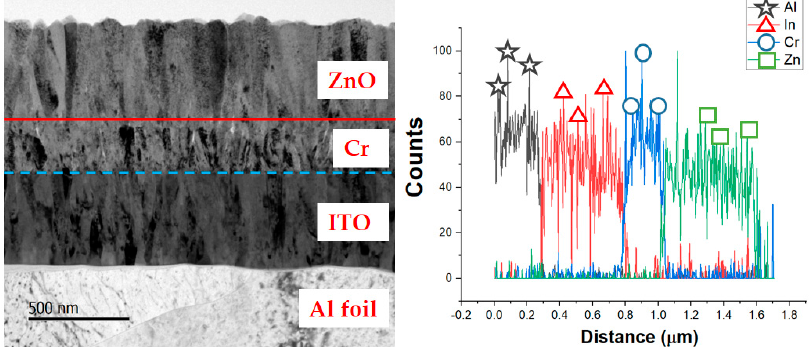
Figure 9. LRTEM (200 KeV) cross-sectional image ( left ) and EDS depth profile ( right ) of the ZnO/Cr/ITO/Al-foil stacked films deposited on the Al-foil substrate. The scale bar represents 500 nm.